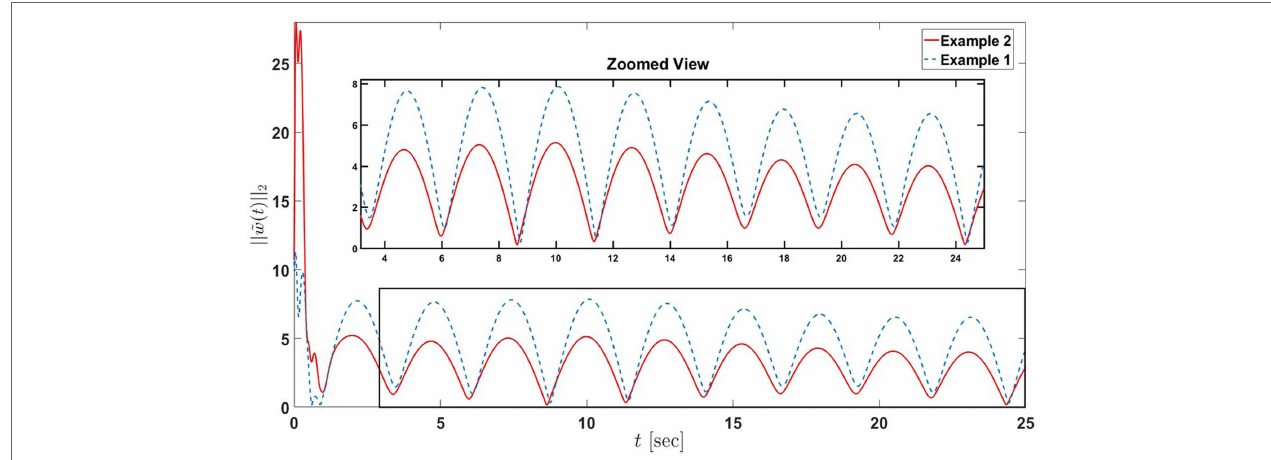
FIGURE 9 | Input error norms of the sensor networks in Example 1 and Example 2.